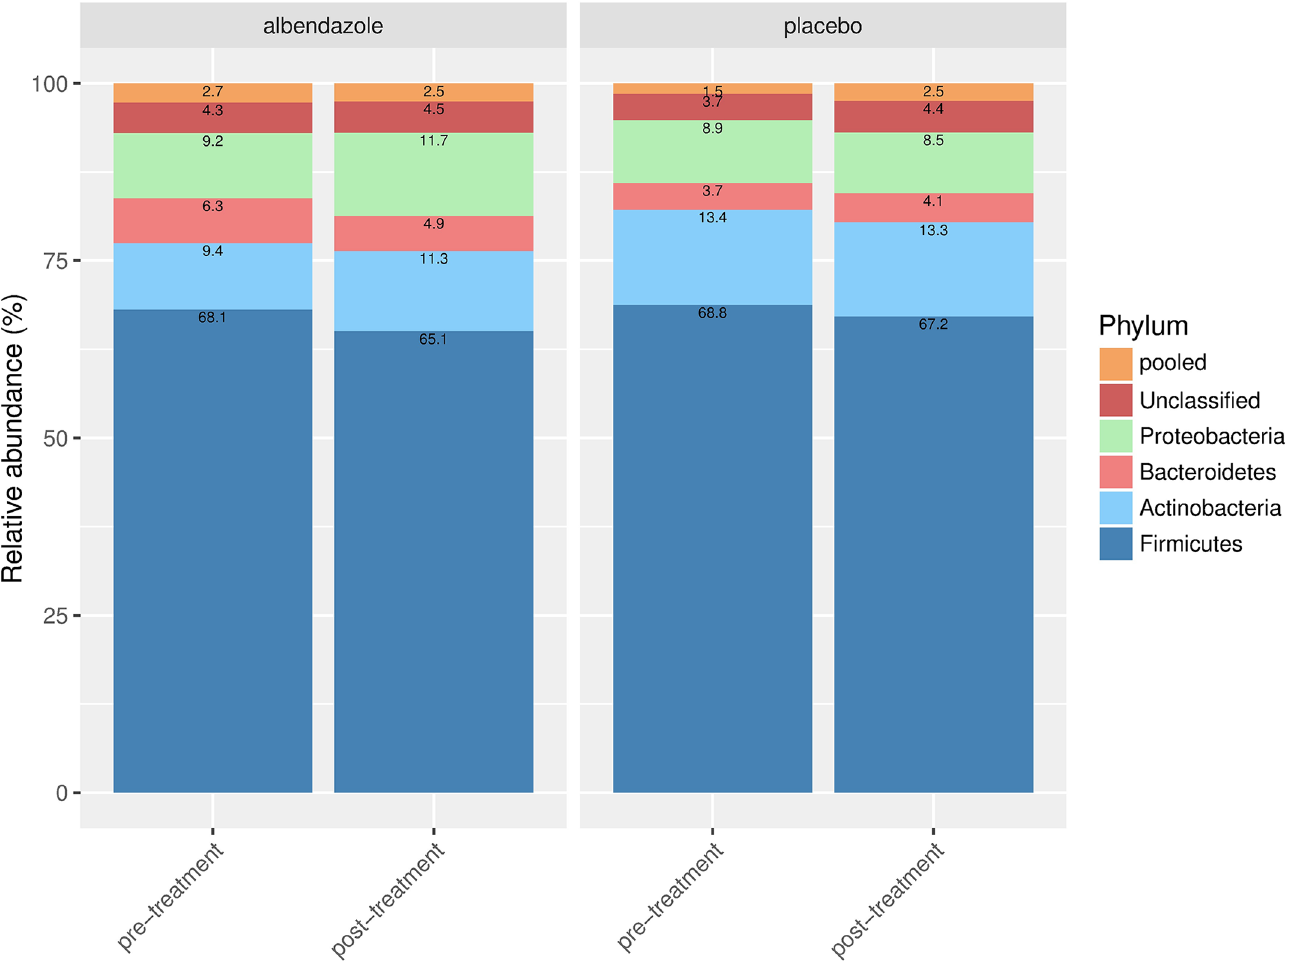
Fig 5. Direct treatment effect on microbiome composition. Details for the stacked barplots were as given in Fig 4. The microbiome composition is shown at pre and post-treatment for subjects who were uninfected at pre-treatment and remained uninfected at post-treatment in albendazole and placebo